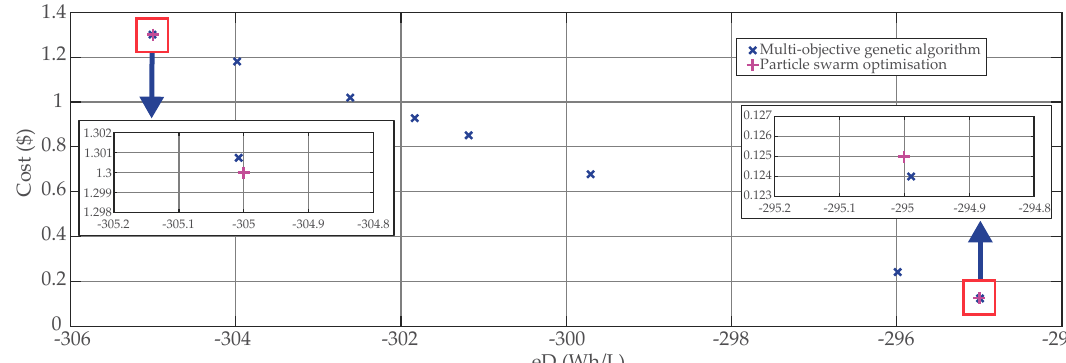
Figure 15. Optimal solution space with the multi-objective genetic algorithm and the particle swarm optimisation for the optimisation